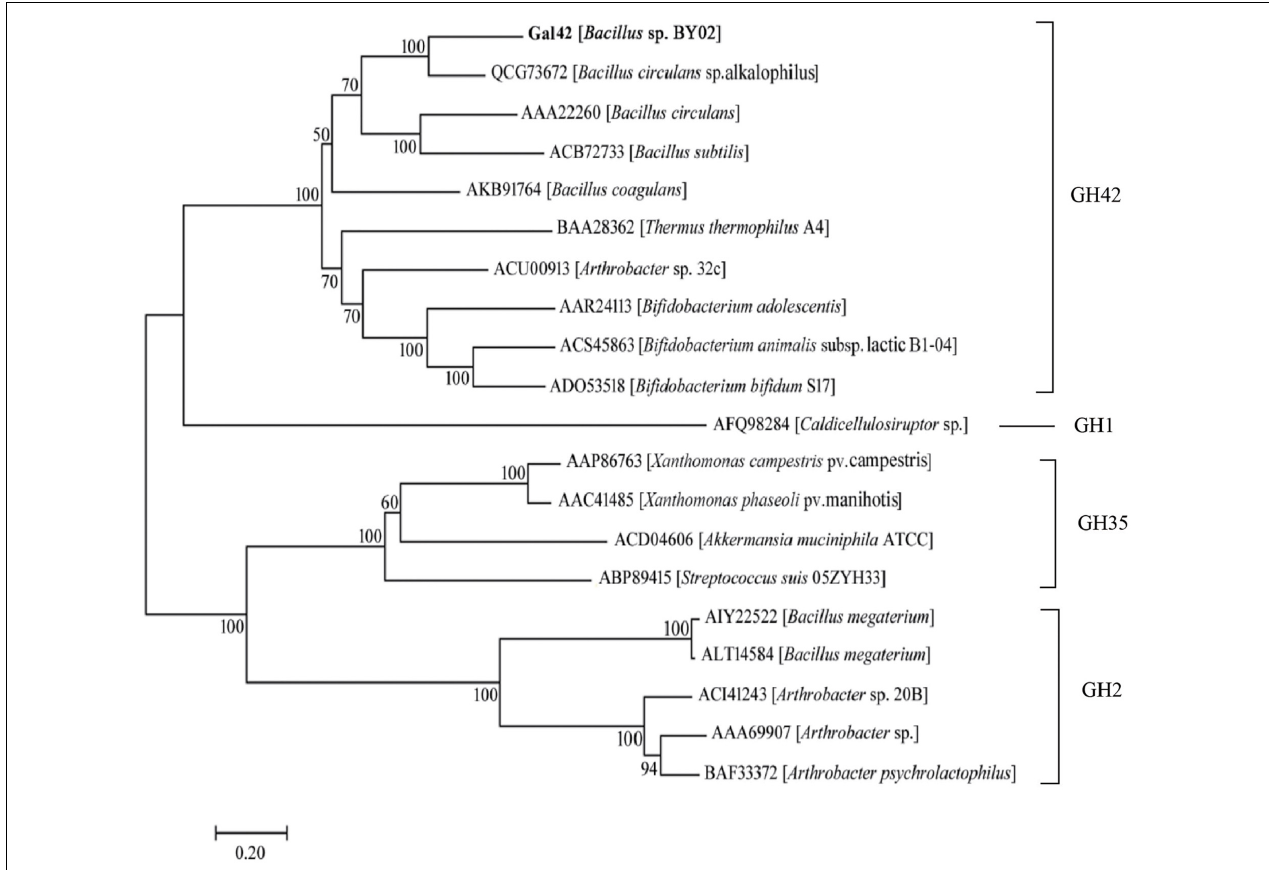
FIGURE 1 | Evolutionary analysis of β -galactosidases. The phylogenetic tree of Gal42 and other β -galactosidases was constructed using the ClustalX program based the reference 16S rDNA sequences, which were collected from the National Center for Biotechnology Information (NCBI) database. The phylogenetic tree (1,000 bootstraps) was constructed using the MEGA 7.0 program via neighbor-joining method.